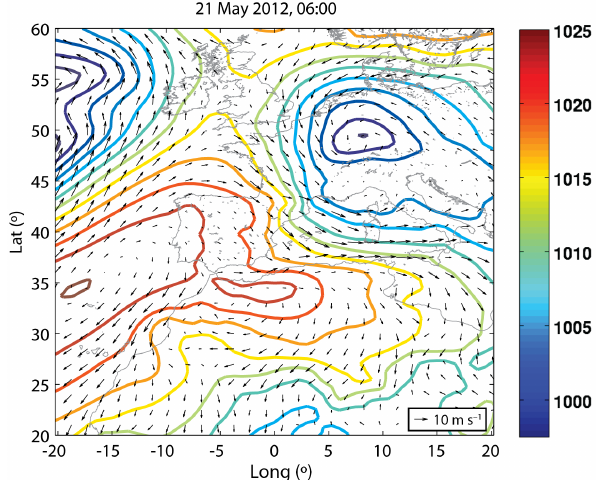
Figure 2. Regional chart of the mean sea level pressure (hPa) during 21 May at 06:00UTC (representative of the synoptic situation dur- ing the selected cross-shelf wind event). Data source: ERA-Interim global reanalysis from ECMWF. Arrows represent the wind field.